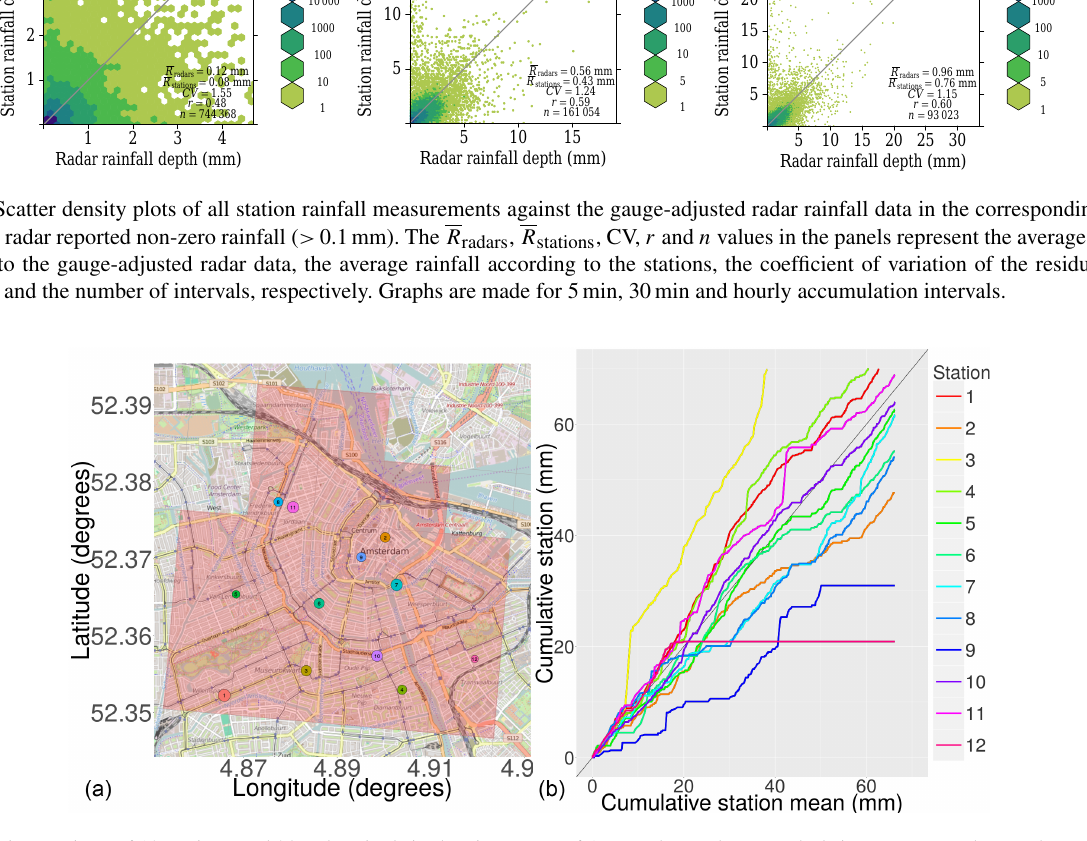
Figure 9. (a) Locations of 12 stations and 20 radar pixels in the city center of Amsterdam, where symbol size represents the number of unique days with measurements by the station (range of 371–514 days). The background map is taken from © OpenStreetMap (www.openstreetmap. org). (b) Double mass plots of the station measurements as compared to the mean of all 12 stations over the intervals where all stations contain